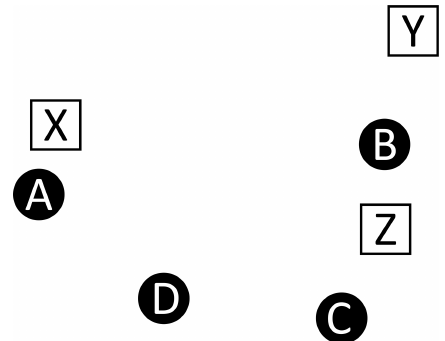
Figure A1. Correspondence. This example illustrates a case where recovered peaks (white squares) are slightly offset from the injected master peaks (black circles). One injected peak (D) is not recovered and the offset introduces challenges relating to the correspondence between the two lists, as described in Table A2.